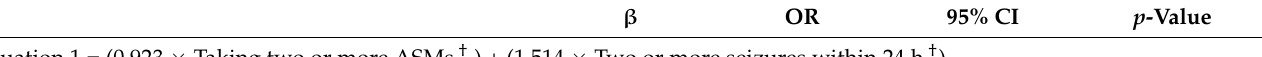
Table 3. Cont. Model 1. Variable Selection Using Logistic Regression Analysis.